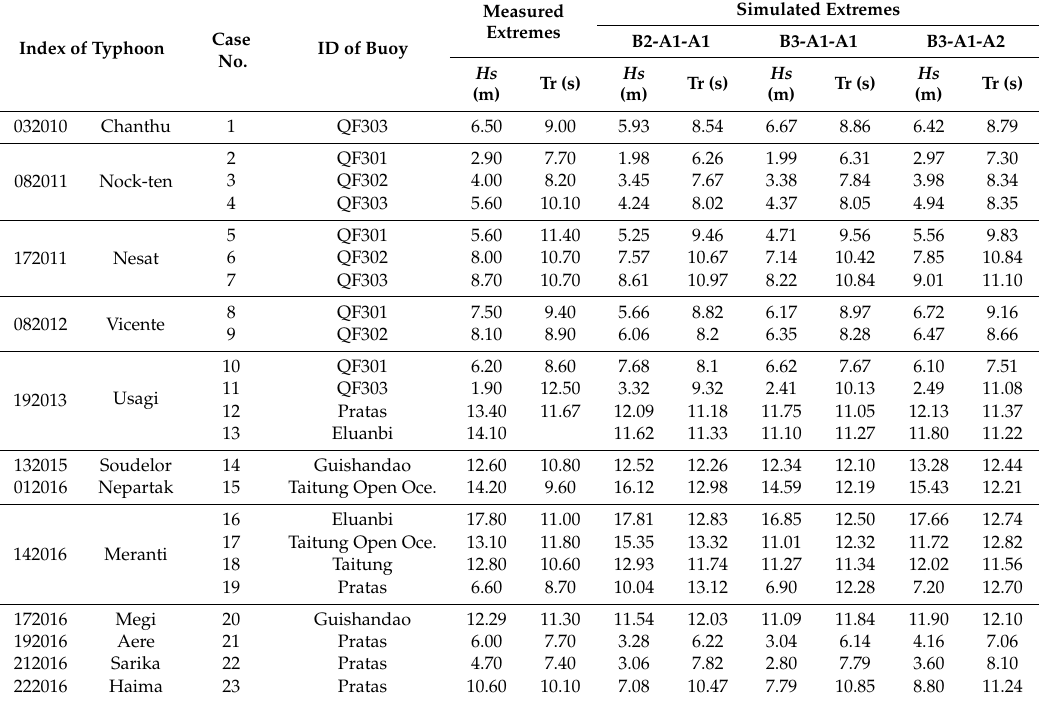
Table A1. Paired peak-value of buoy extremes and simulated extremes in every